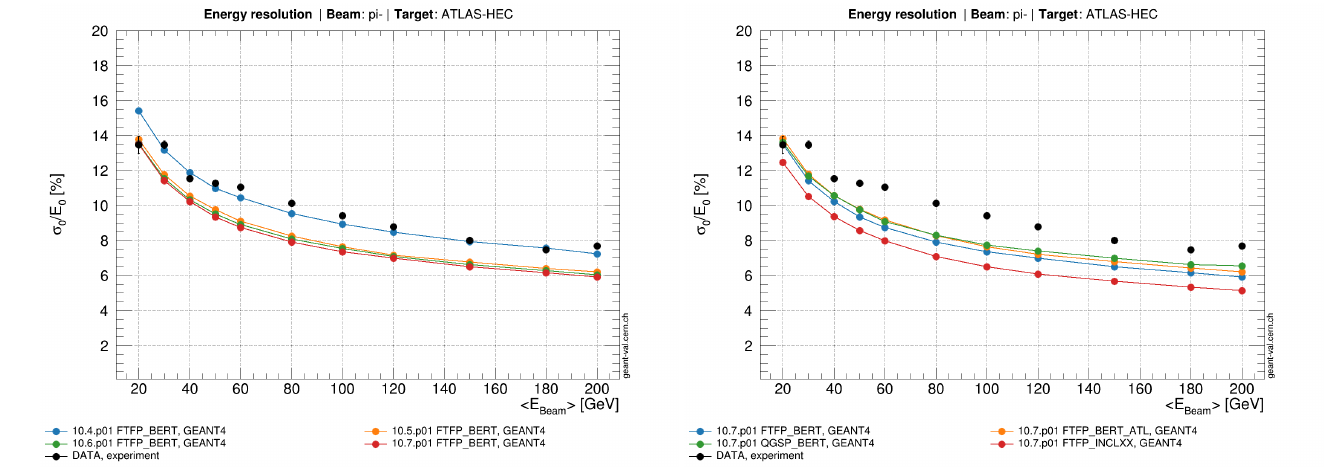
Figure 3. Left : σ / E comparison of the Geant4 FTFP_BERT PL prediction for recent releases (2017–2020) with the experimental data. Right : Comparison of several PL predictions from Geant4 10.7.p01 for the same